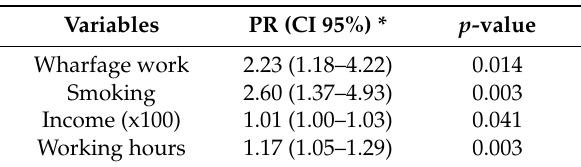
Table 3. Occupational and personal factors associated with increased use of illegal drugs among dockworkers in the interior of Rio Grande do Sul, RS, Brazil.